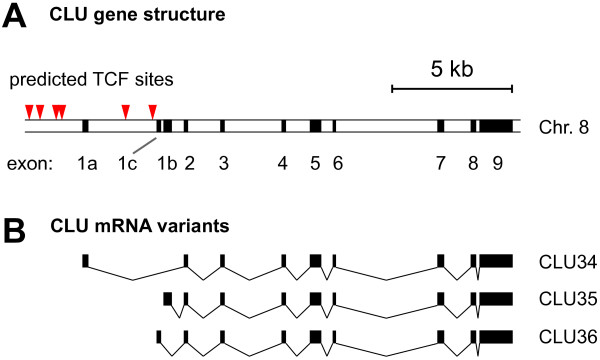
Genomic structure of CLU locus and exon-composition of CLU mRNA variants expressed in colonic cells. (A) Diagram depicts the genomic location of all CLU exons on chromosome 8 and potential TCF-binding sites (red arrows) predicted by the MatInspector software. (B) Exonic structure of CLU mRNA variants.